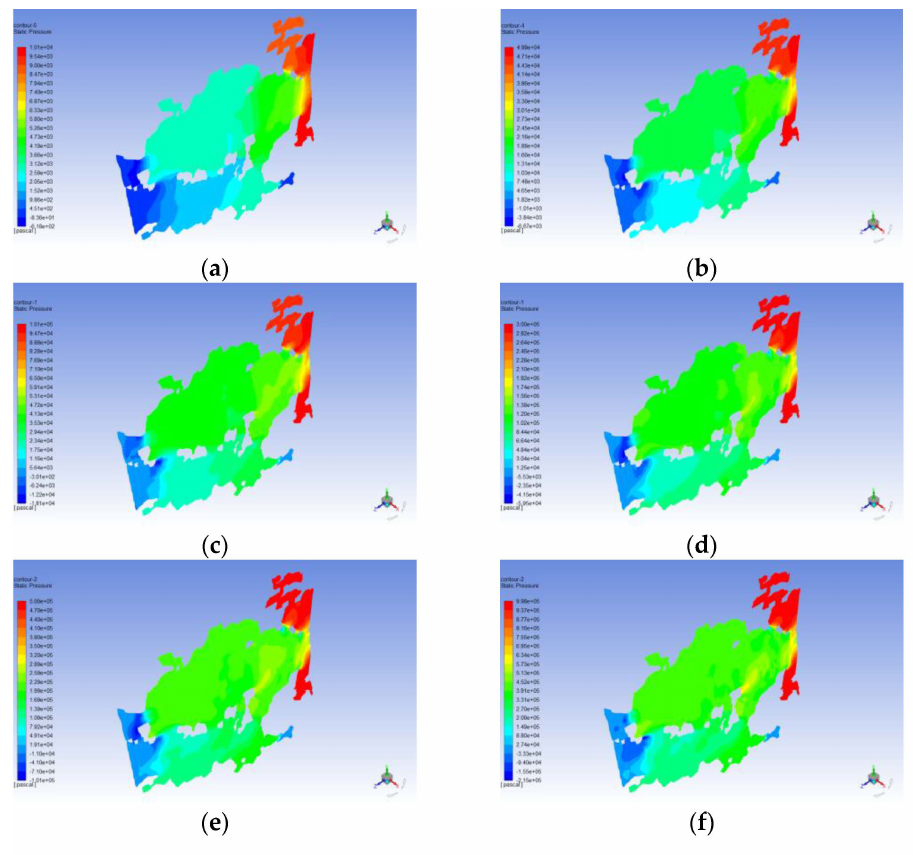
Figure 3. z forward inlet pressure cloud map: ( a ) 0.1 Mpa pressure cloud map. ( b ) 0.5 Mpa pressure cloud map. ( c ) 1 Mpa pressure cloud map. ( d ) 3 Mpa pressure cloud map. ( e ) 5 Mpa pressure cloud map. ( f ) 10 Mpa pressure cloud